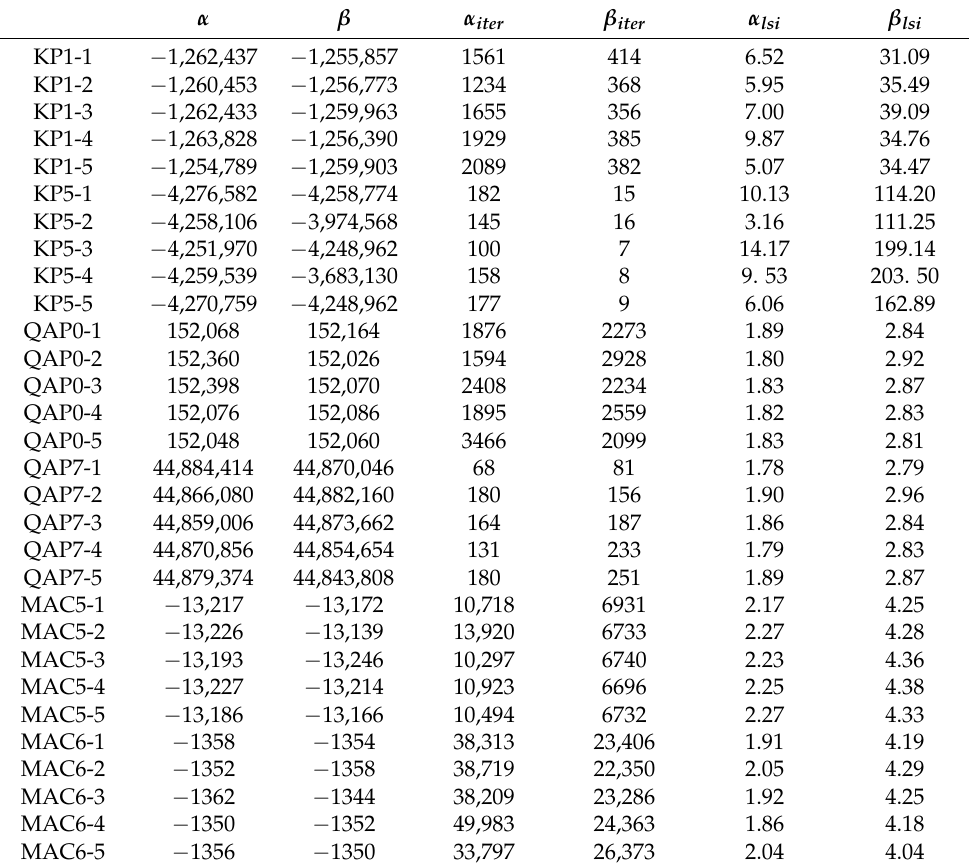
Table 14. Test Results from the Overlapping Runs of the two EA-ILS